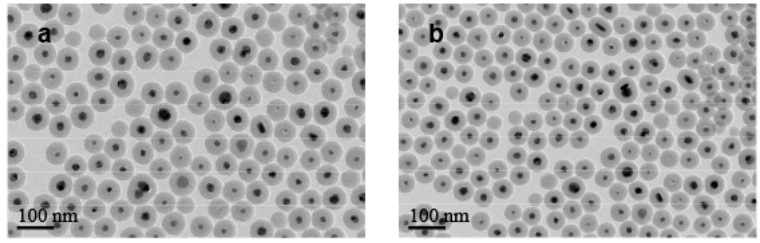
Figure 9. Characterization of the without-mesoporous nanoparticles prepared by reverse micelle technique by TEM images: ( a ) before and ( b ) after nitrobenzene hydrogenation.